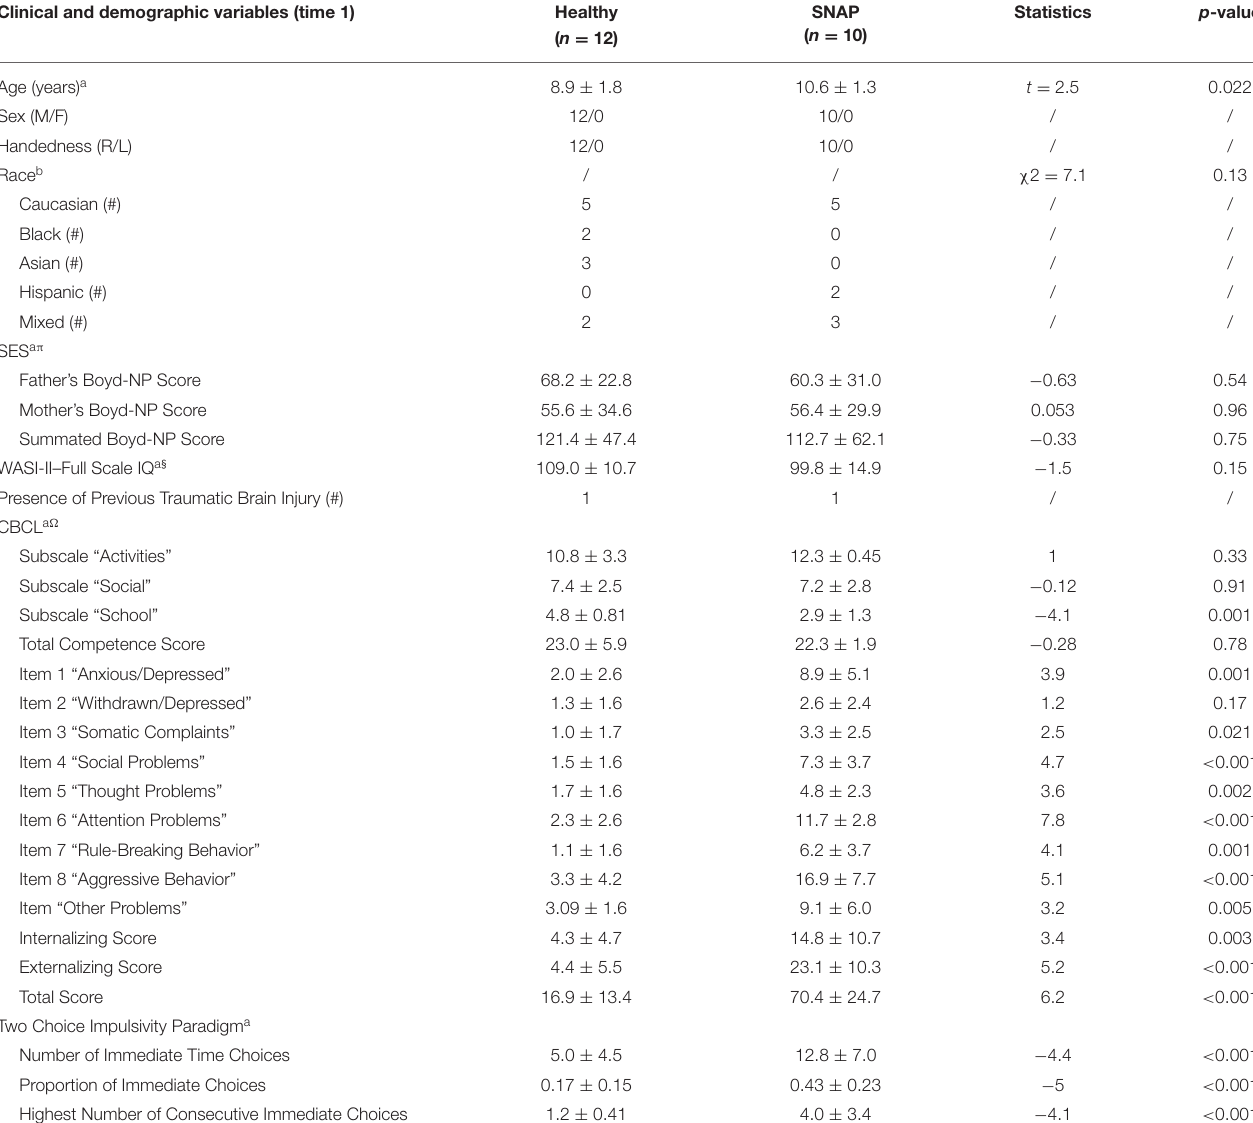
TABLE 2 | Clinical and demographic variables of SNAP and control youth at time 1. Clinical and demographic variables (time